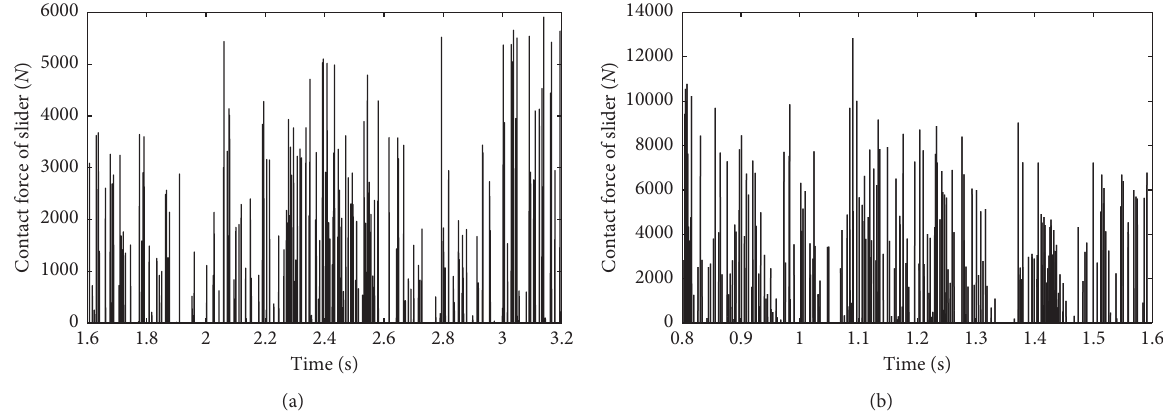
Figure 21: Contact force of the slider. (a) ω